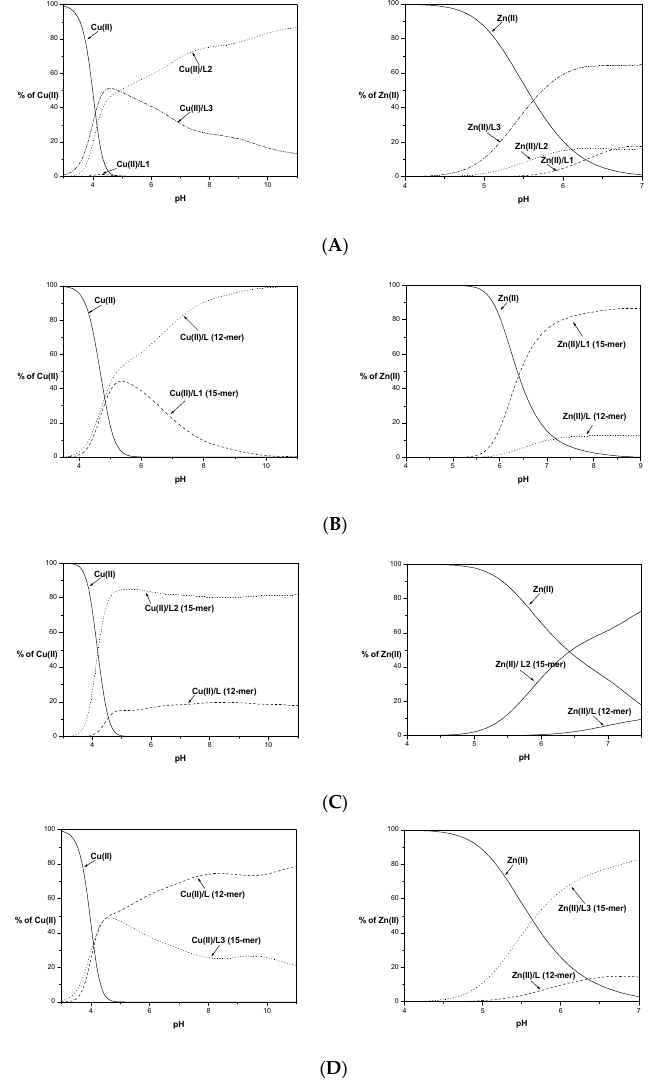
Figure 3. Competition diagram between Cu(II) and Zn(II) complexes of 15-mers: L1, L2, and L3 ( A ) and 15-mers with 12-mers ( B – D ), describing complex formation at different pH values in a hypothetical situation. Calculations are based on binding constants from Table 2 and [13]. M(II) to peptide molar ratio 1:1.1; T = 25 °C; I = 0.1 M; [M(II)] = [L1–3] = 0.001 M.